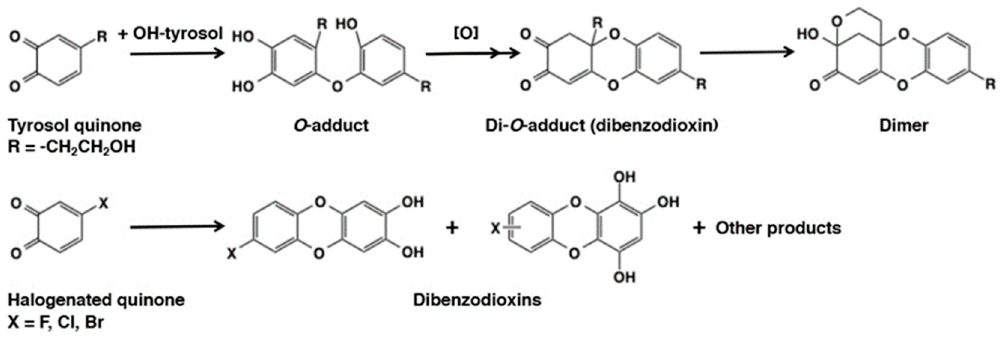
Figure 14. Self-coupling of tyrosol quinone with hydroxytyrosol (HT) to form a dibenzodioxin [64]. An isomer differing in the position of the substituent (R-) was also isolated. An efficient formation of dibenzodioxins was reported for 4-halogenated quinones [65].